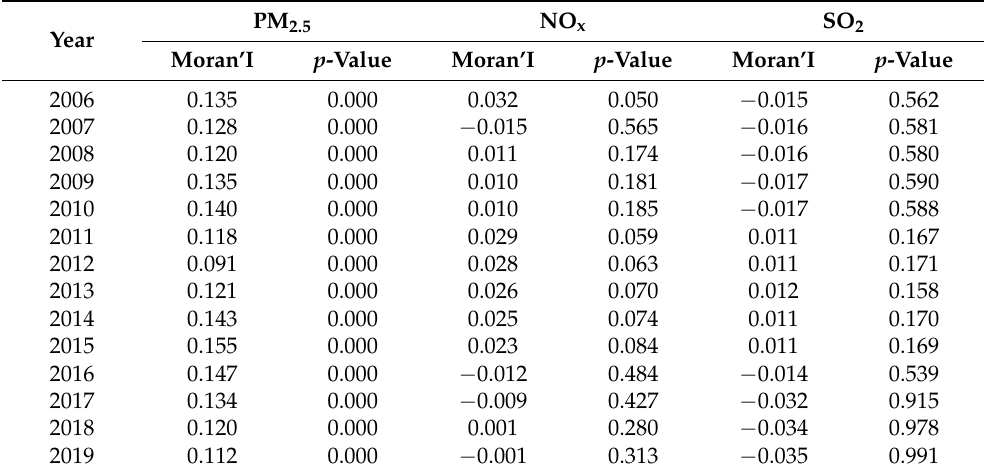
Table 9. Moran index of PM 2.5 , NO x , SO 2 emissions for 29 provinces in China, 2006–2019.